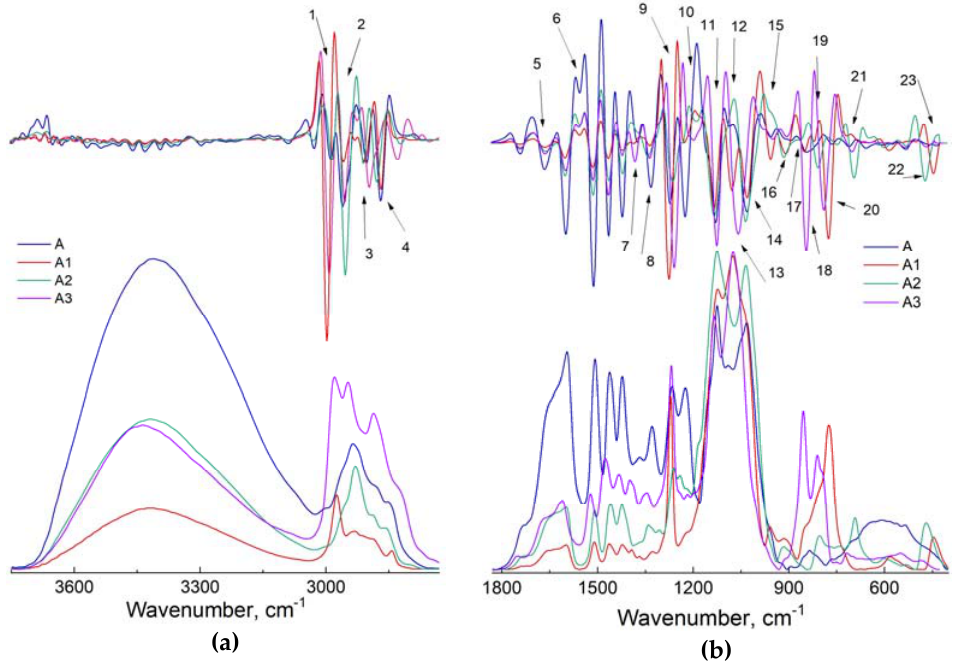
Figure 5. Infrared spectra and their derivatives for the untreated archaeological elm wood (A) and silane-treated samples (A1, A2, A3, respectively) in 3750–2750 cm − 1 ( a ) and 1800–400 cm − 1 ( b )